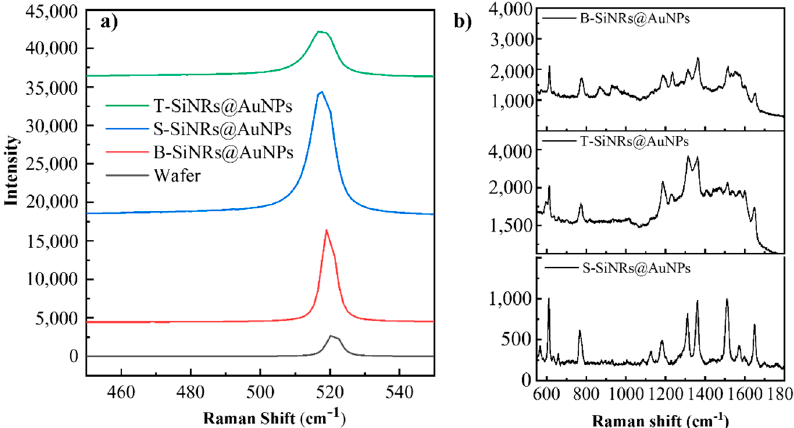
Figure 4. Raman measurements on different SERS substrates. ( a ) Si Raman signals (520.7 cm − 1 ) from three types of substrates and Si wafer; ( b ) R6G Raman detection by B-SiNRs@AuNPs, T-SiNRs@AuNPs and S-SiNRs@AuNPs SERS substrates.